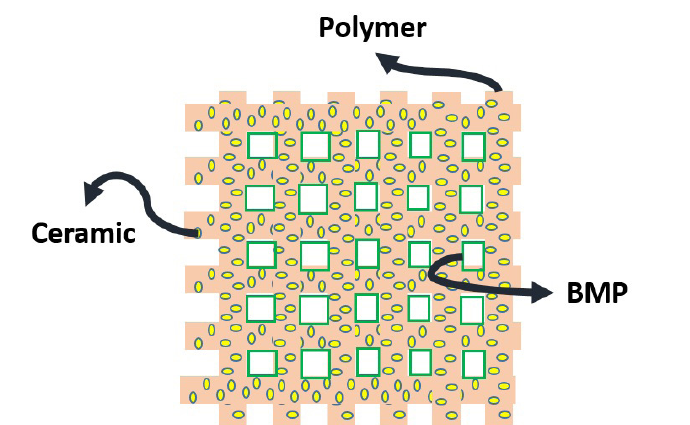
Figure 4. Scaffolds for rhBMP-2